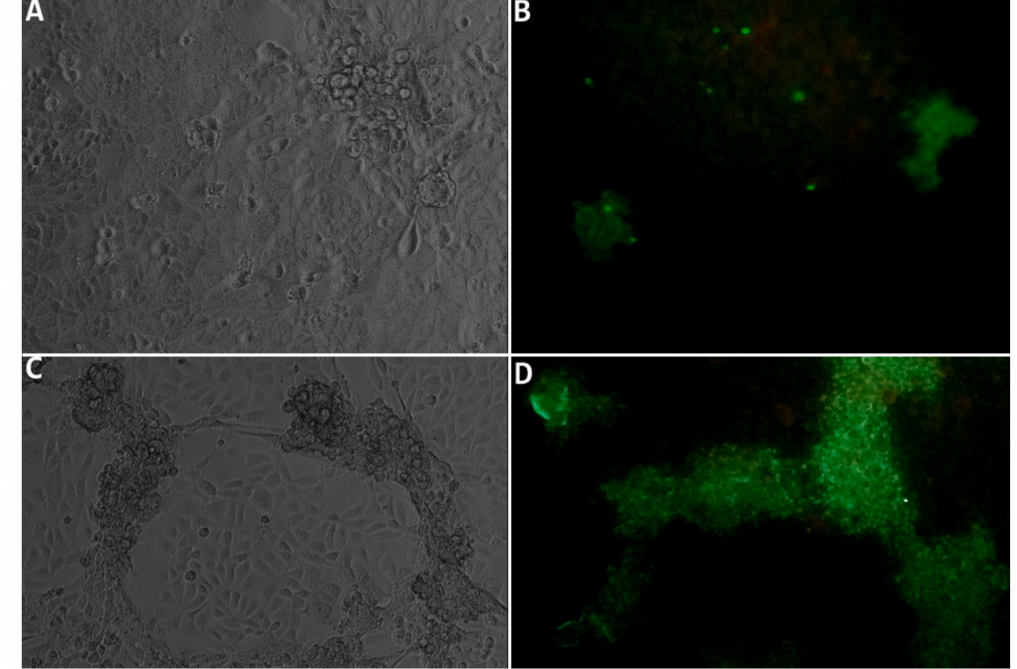
Figure 6. ( A ) Cytopathic e ff ect in RK13 cells infected with an eyelid homogenate of the rabbit